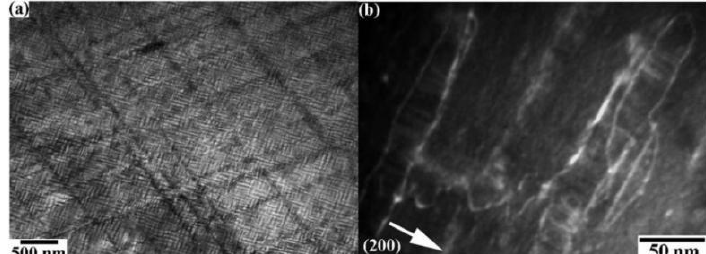
Figure 7. ( a ) TEM image of planar dislocation arrangements, ( b ) weak beam TEM images of dislocation/κ -carbides interactions in Fe-30.5Mn-8.0Al-1.2C (wt.%) steel aged at 600 °C for 24 h and tensile deformed to 0.15 true strain: diffraction vectors are indicated by arrows. (Reprinted with permission from [10] , copyright Taylor and Francis, 2014).